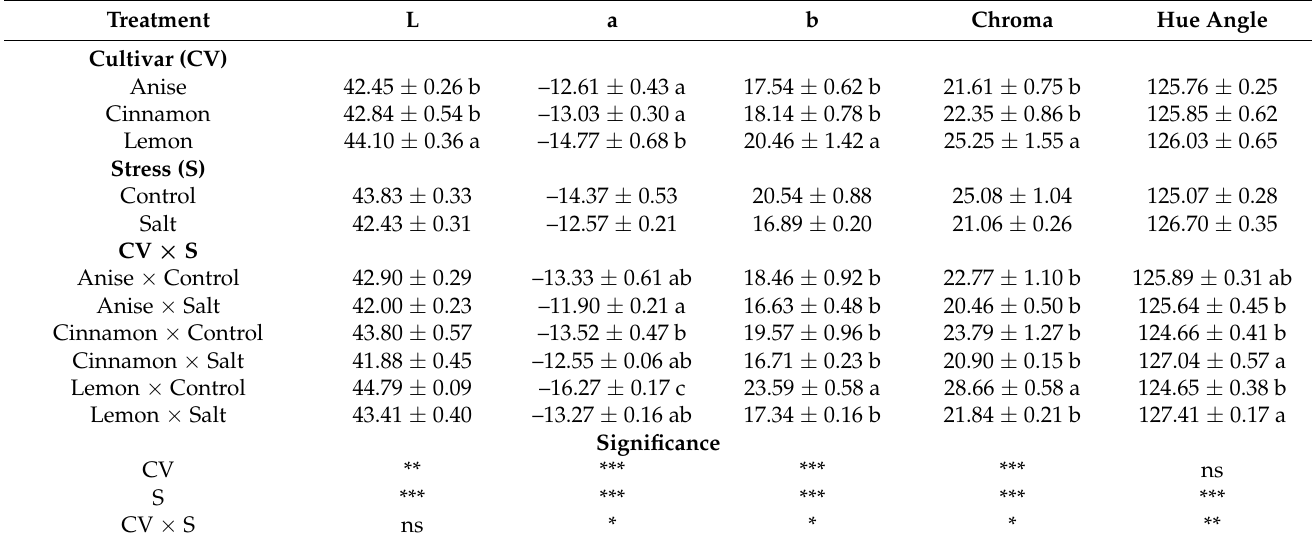
Table 1. Effect of basil cultivars (CV) and stress (S) on CIELab colorimetric indices.